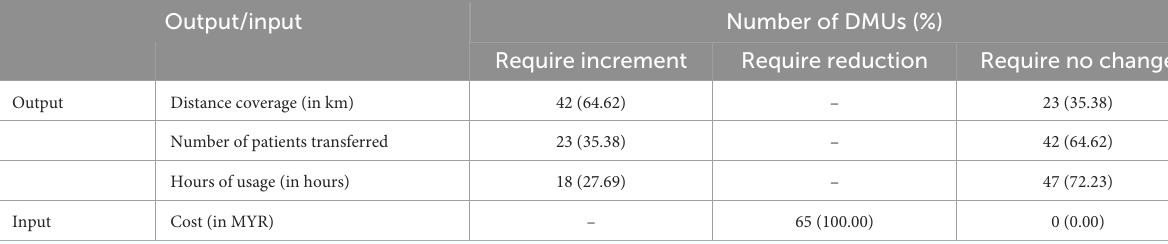
TABLE 4 DMUs required improvement in outputs and input for ambulance services ( n = 65).